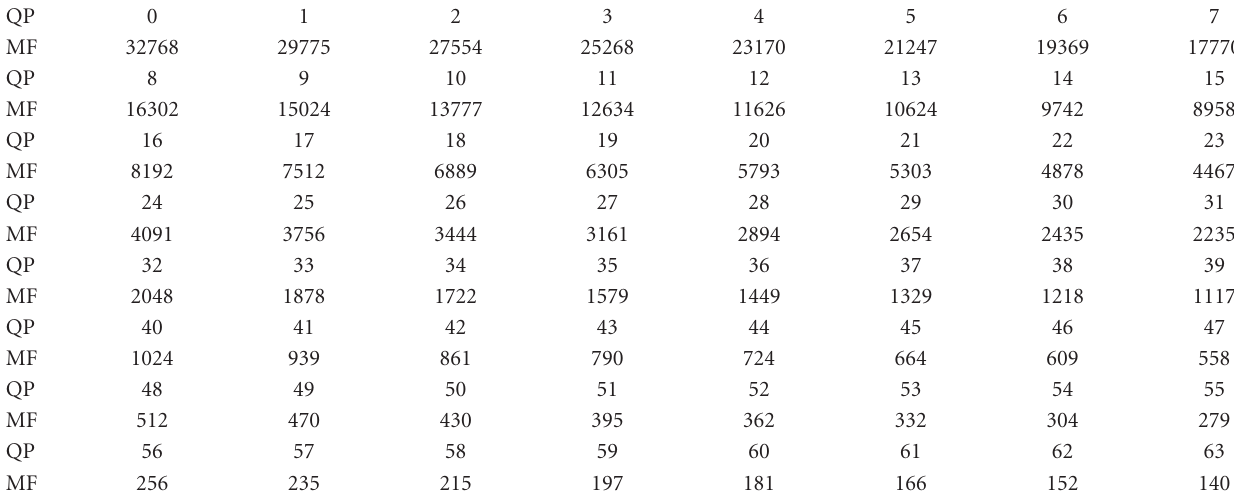
Table 2: Quantization table for AVS encoder.